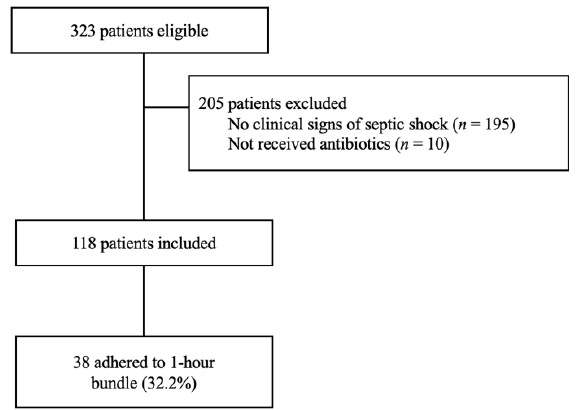
Figure 1. Study Figure 1. Study flowchart.